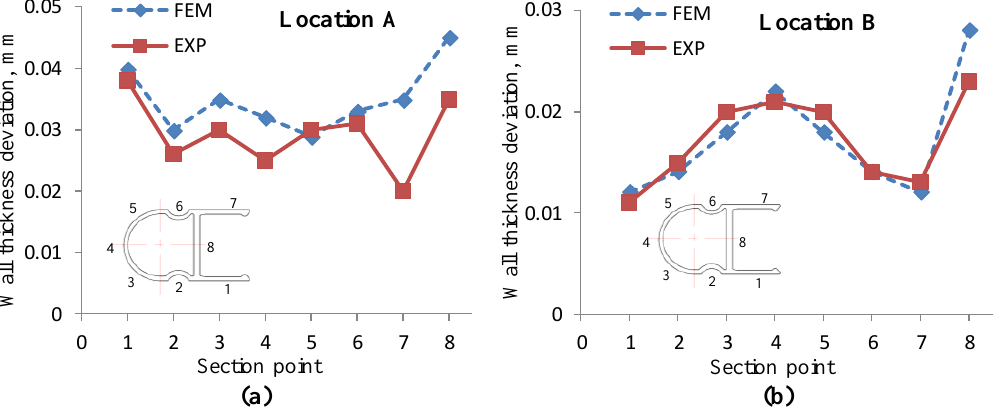
Figure 13. Comparison of wall thickness deviation between experimental and simulation results: ( a ) Location A and ( b ) Location B.